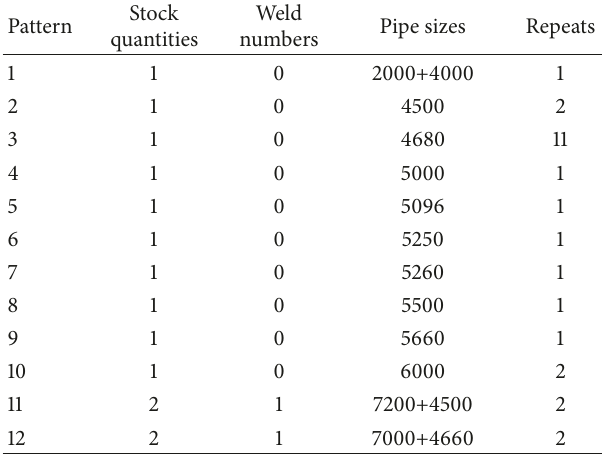
Table 3: Minimal cutting-and-welding patterns for 𝜋 𝑤 = 0.9𝜋 1 .